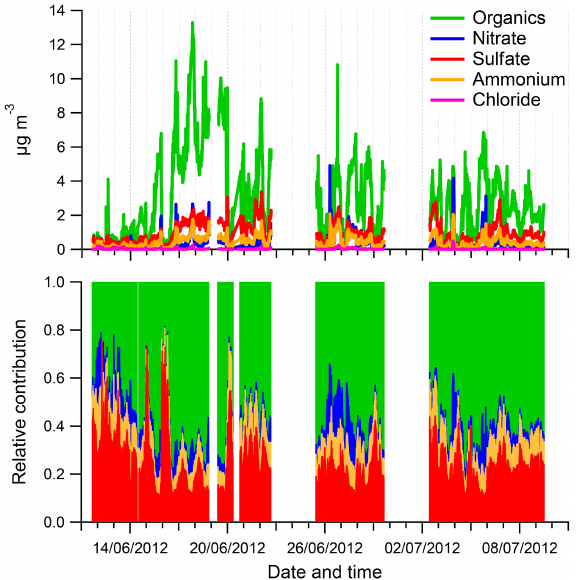
Figure 1. Time series and relative contribution of the main NR-PM 1 components. Time is local (UTC + 2h).